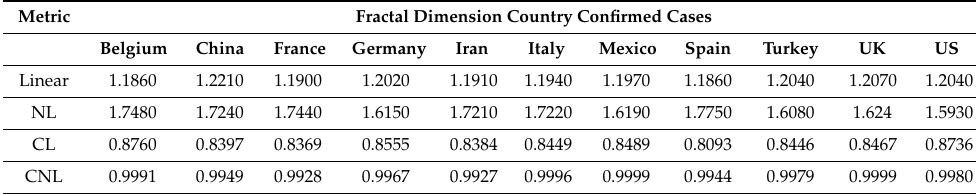
Table 1. Fractal dimensions for confirmed cases in the countries.